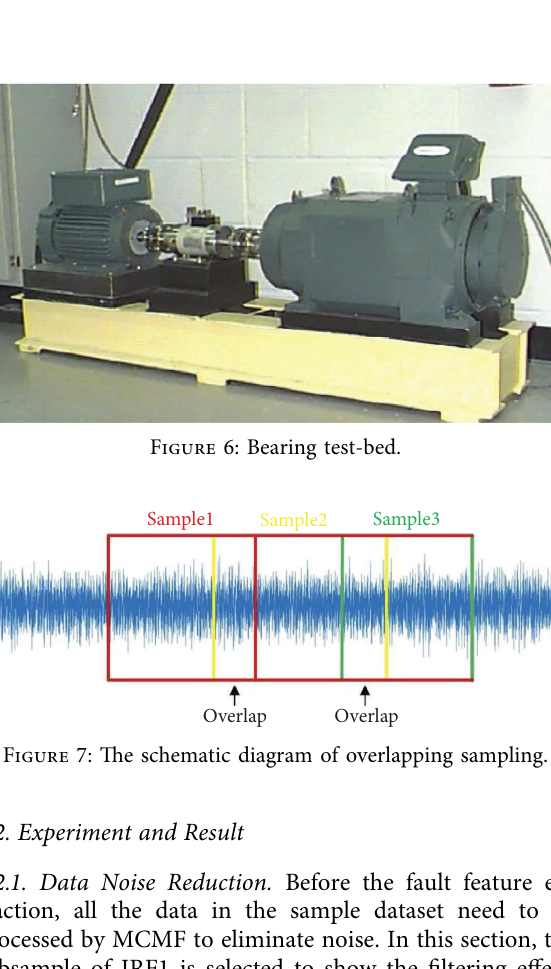
Figure 5: MFE and IMFE of Gaussian white noise with diferent N . (a) MFE of Gaussian white noise with diferent N . (b) IMFE of Gaussian white noise with diferent N .